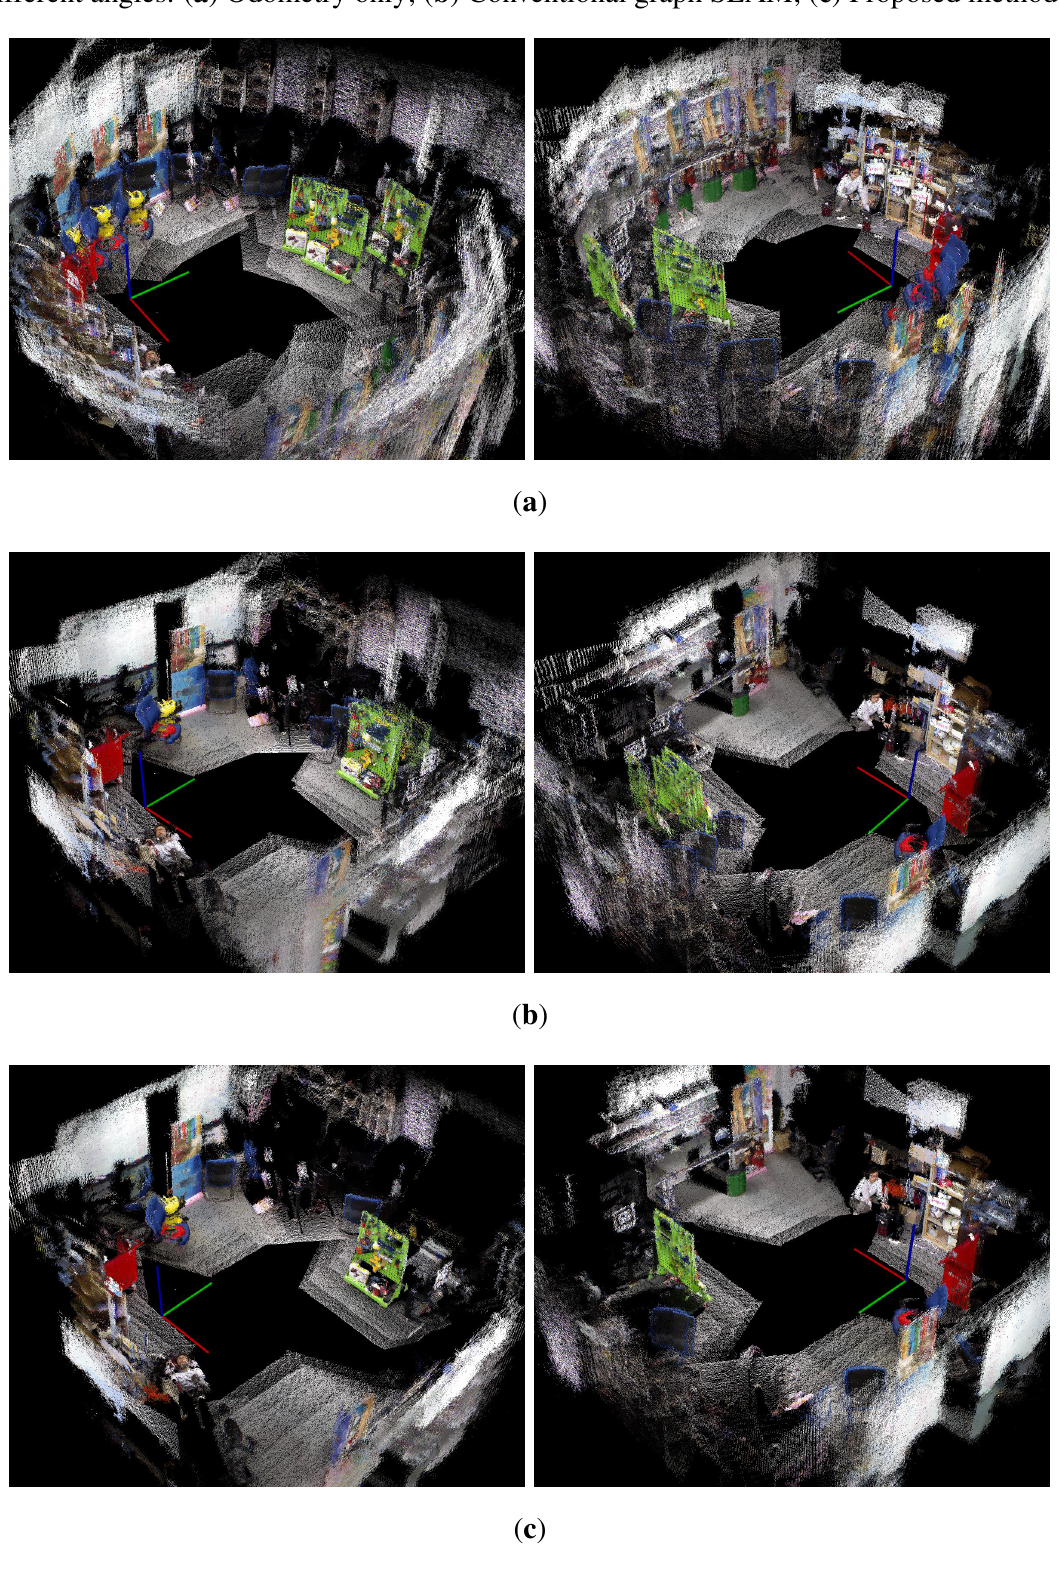
Figure 27. The 3D maps obtained from experiment 1. Left and right columns are views from different angles. ( a ) Odometry only; ( b ) Conventional graph SLAM; ( c ) Proposed